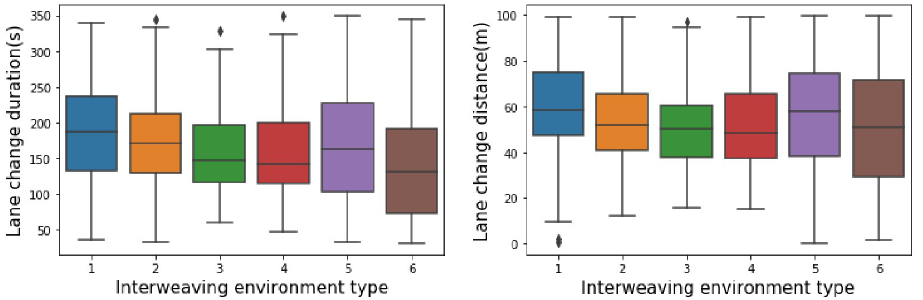
Fig 11. Box diagrams of the lane-changing duration and